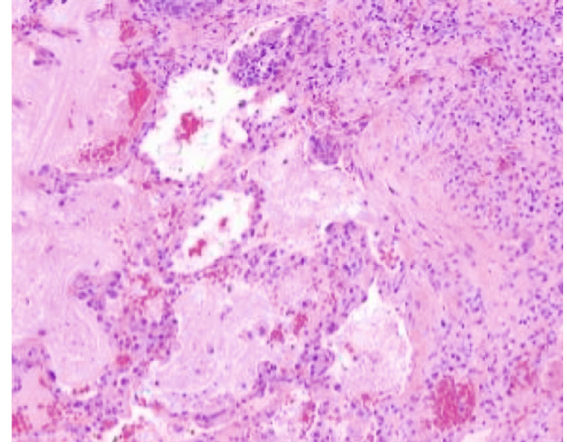
Figure 6: Isolated fi broblastic foci (hematoxylin and eosin